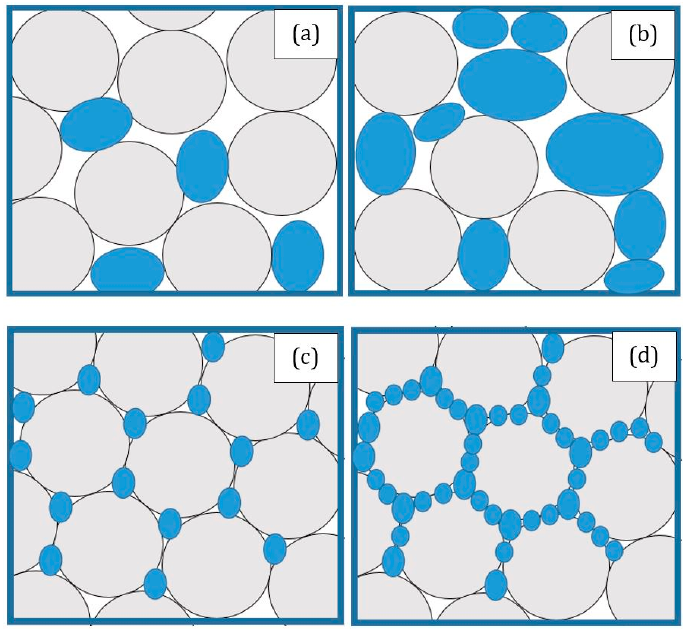
Figure 2. Illustration of random ( a , b ) and segregated ( c , d ) distributions of metal particles in polymer composites.